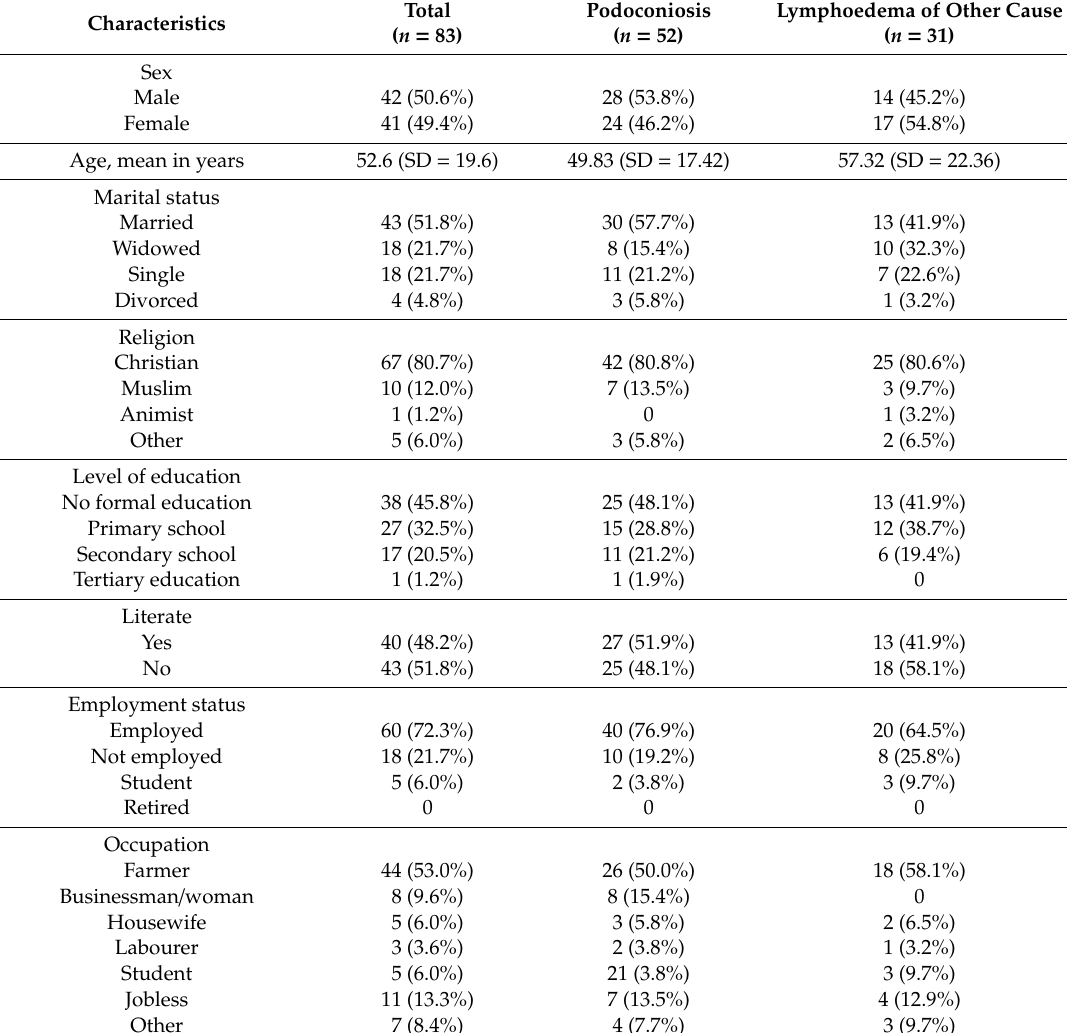
Table 1. Socio-demographic and disease characteristics of people with lower limb lymphoedema in